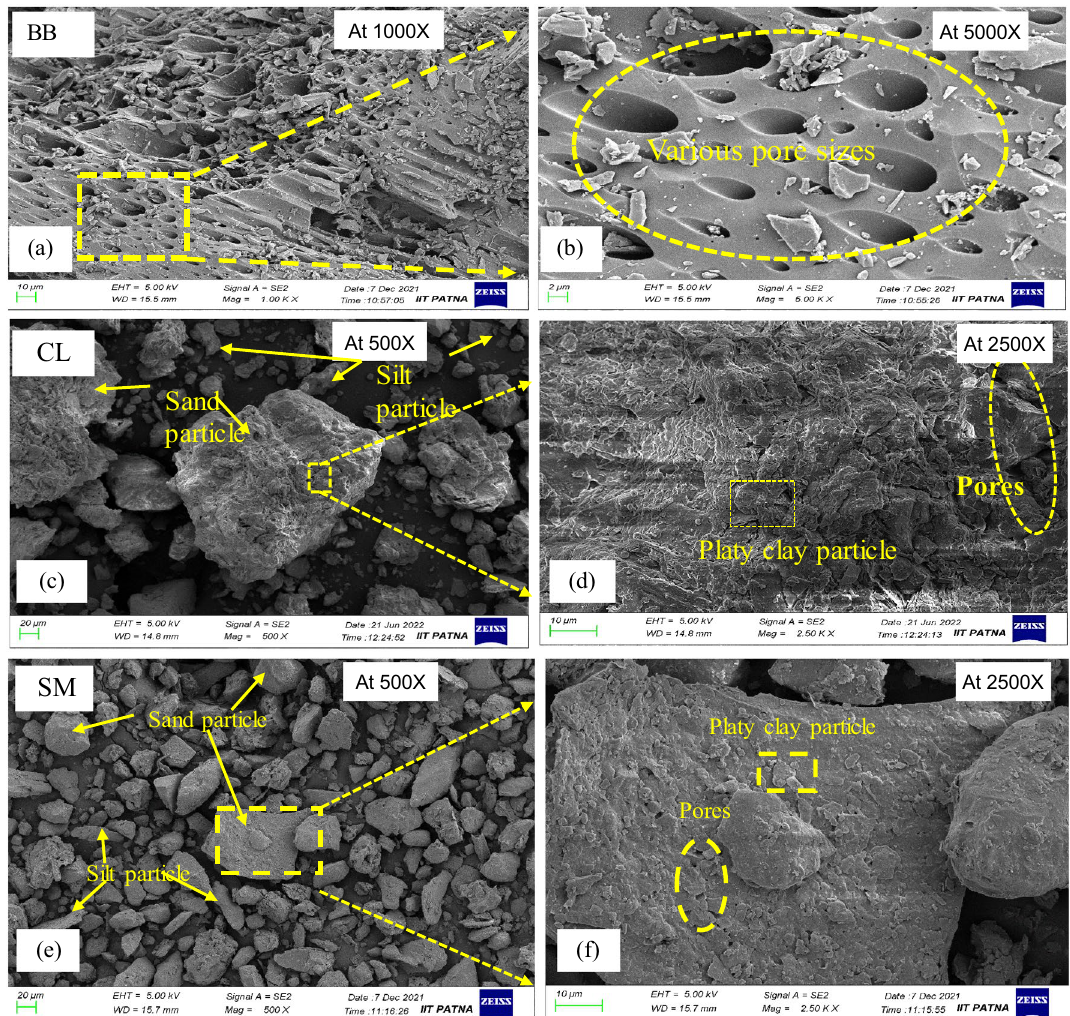
Figure 2. Surface morphology of ( a , b ) bamboo biochar; ( c , d ) CL and ( e , f ) SM soil at different magnifications in powder